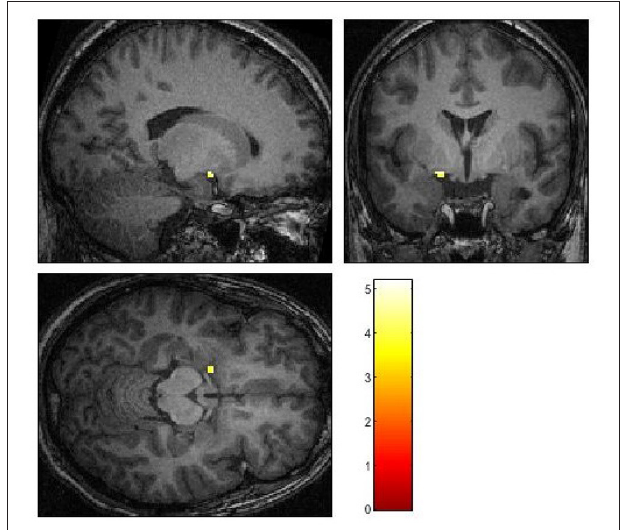
FIGURE 2 | Activation patterns in reaction to angry faces in contrast to a baseline condition. p < 0.001,